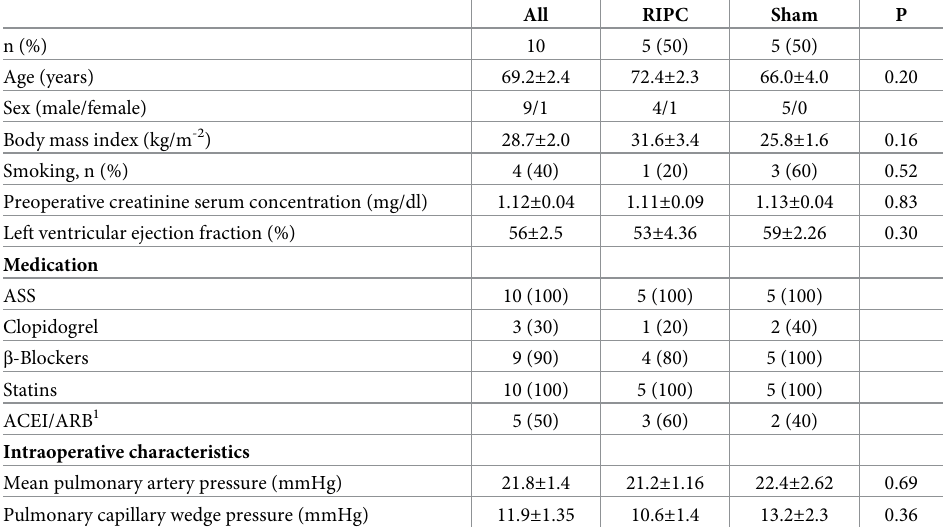
Table 1. Perioperative characteristics of CABG patients undergoing RIPC or Sham under isoflurane / sufentanil anesthesia.